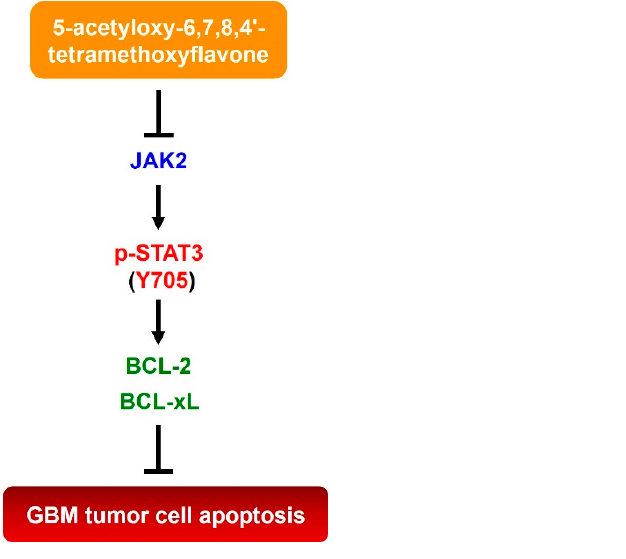
Figure 7. Schematic model of the mechanism of action underlying 5-AcTMF-elicited anticancer effect on GBM cells established in this study. Briefly, 5-AcTMF thwarts GBM cell survival and clonogenicity via repressing STAT3 activation, likely through inhibition of STAT3 upstream kinase JAK2, to downregulate STAT3 transcriptional targets BCL-2 and BCL-xL, thereby leading to the induction of GBM cell apoptosis.